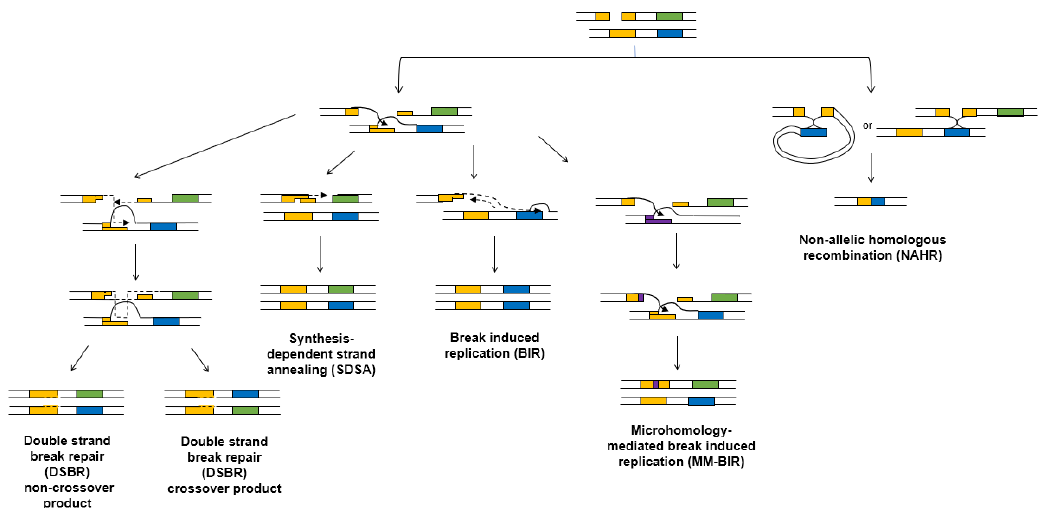
Figure 2. Mutagenic outcomes of homologous recombination. All types of homologous recombination begin with resection to form single-stranded DNA, followed by RAD51-mediated strand invasion. SDSA and DSBR usually use the sister chromatid as a template but the use of the homologous chromosome can result in loss of heterozygosity (SDSA) or mitotic crossovers (DSBR). BIR involves the formation of a mobile D-loop and produces long, single-stranded DNA tracts. BIR can result in loss of heterozygosity and mutations caused by damage in persistent ssDNA. MM-BIR involves multiple rounds of strand invasion, which can cause insertions of heterologous sequences. NAHR occurs when single-stranded DNA invades into a non-allelic template. NAHR can be intrachromosomal or interchromosomal and results in deletions (shown), duplications, and